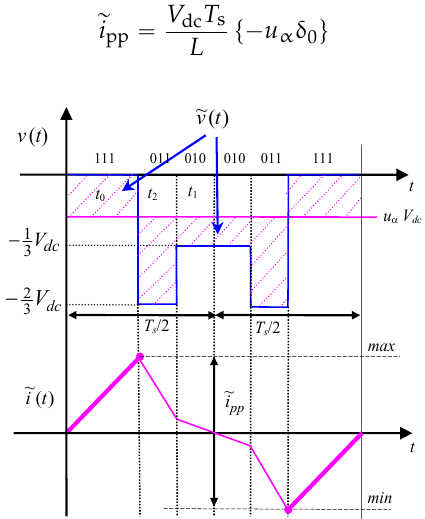
Figure 13. Output voltage and current ripple for DPWM+ technique in one switching period (sector III, − 1/3 ≤ u α ≤ 0).